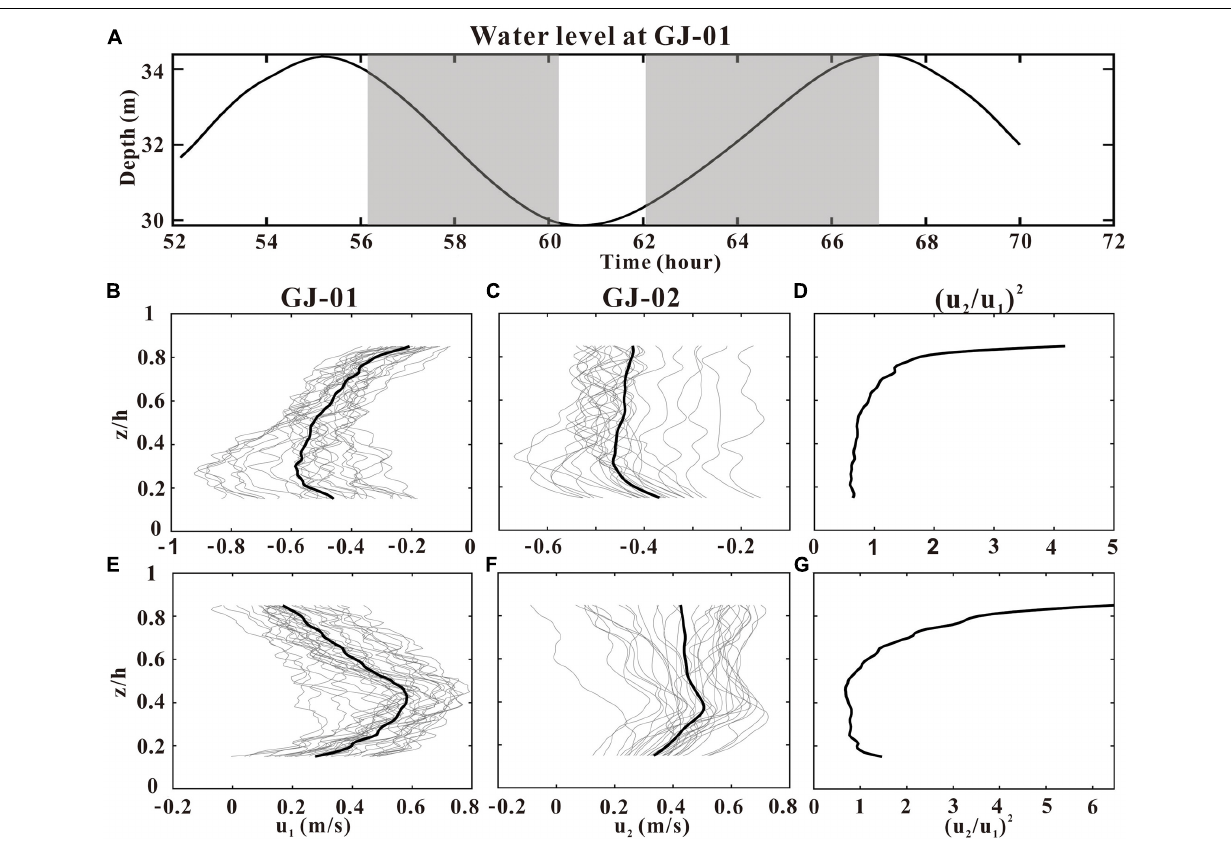
FIGURE 10 | Profiles of u at GJ-01 ( u 1 ) and GJ-02 ( u 2 ) during the ebb (B,C) and flood tides (E,F) . Water-level variations at GJ-01 were plotted in panel (A) with the two selected periods (in gray) when the absolute depth-averaged u was larger than 0.2 m/s. The gray and black curves in panels (B,C,E,F) were plotted using the 10-min average u data and the average u data over the two selected periods. The ratio of u squared at GJ-02 and GJ-01 was plotted in panels (D,G) . z is the height above the bed, and h is the water